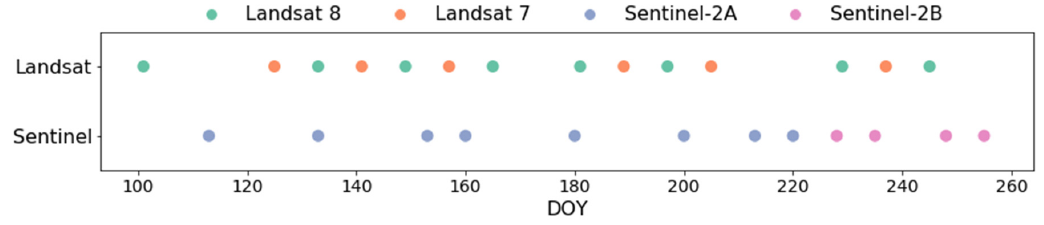
Figure 3. Data availability of Landsat and Sentinel-2 imaginary. Each dot represents an acquisition of Landsat or Sentinel-2 image from 1 April to 30 September 2017, in Saunders, NE. The x-axis shows the DOY (day of the year) from April 1 (DOY 91) to September 30 (DOY 273). Images with clear pixels less than 75% were removed and not shown.